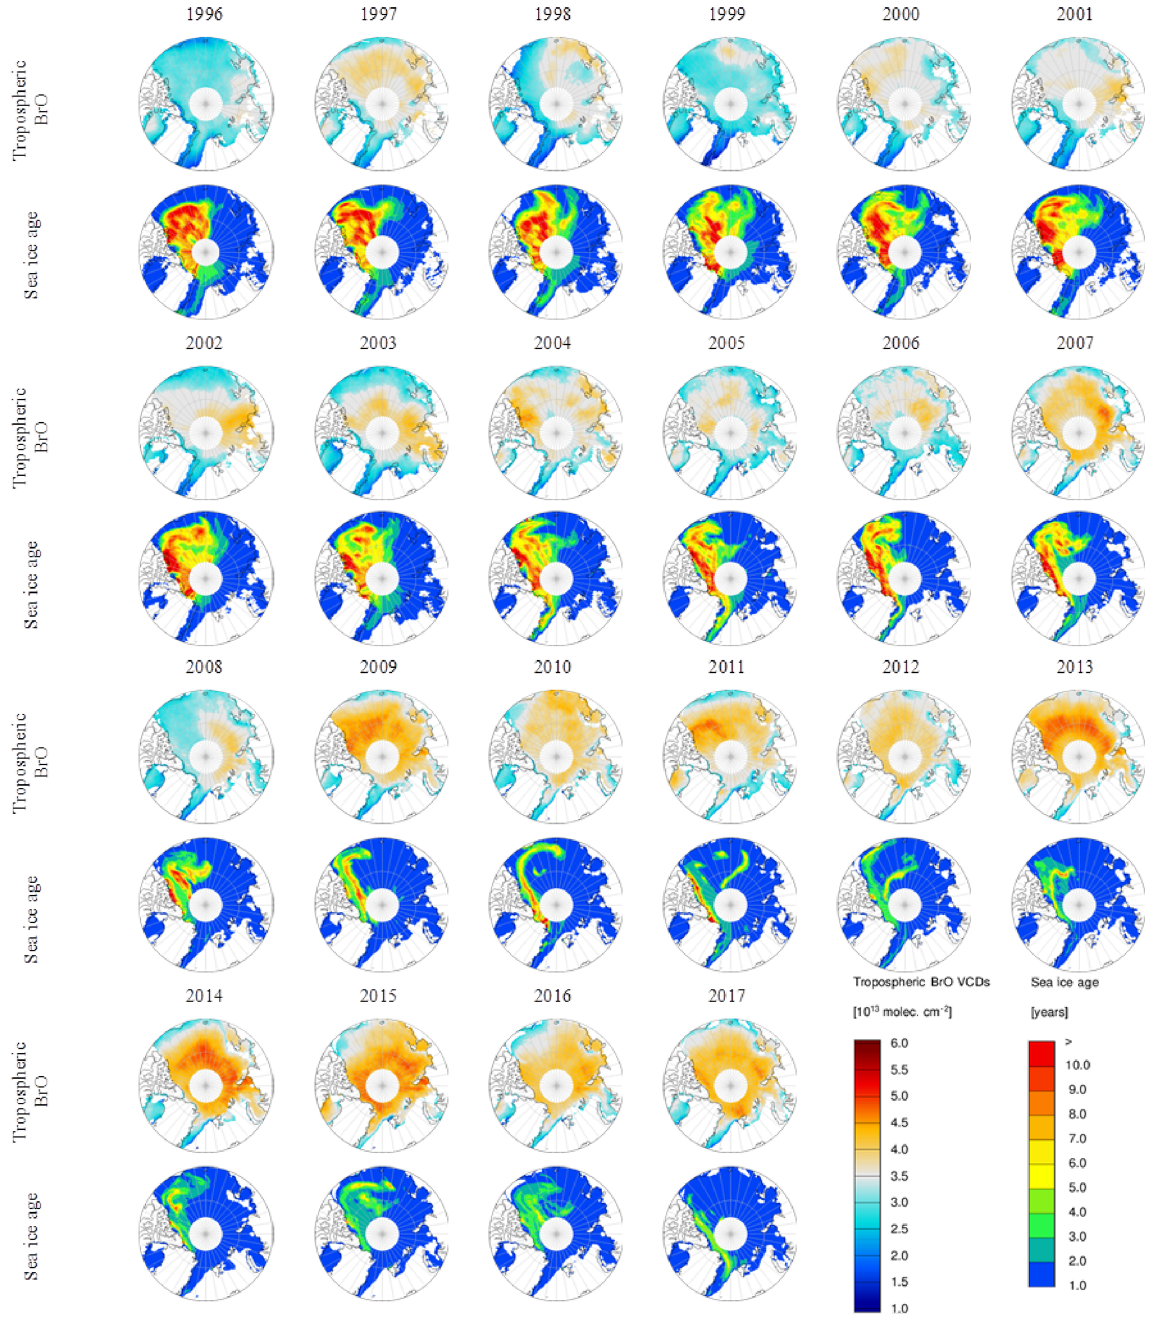
Figure 9. Polar spring (March, April and May, MAM) averages of tropospheric BrO VCDs (10 13 moleccm − 2 ) over sea ice, compared to sea ice age in the Arctic. Columns refer to years, odd rows to tropospheric BrO VCDs and even rows to sea ice